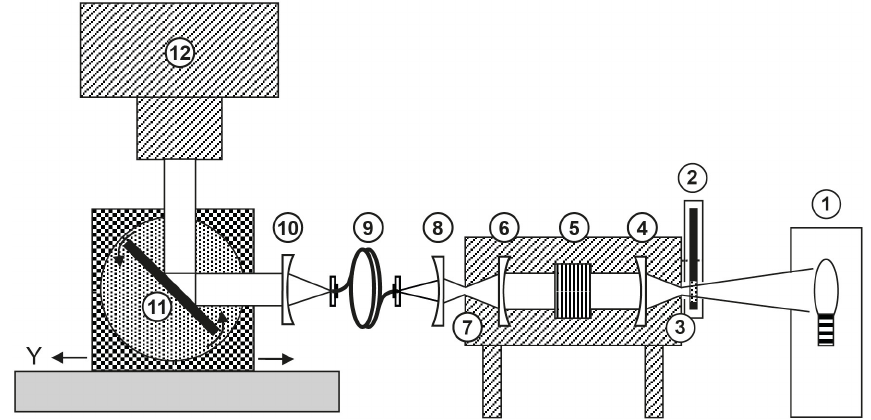
Figure 4: Monochromator setup for spectral measurements. 1 (cid:13) Lamp, 2 (cid:13) Long pass and/or neutral density filter in turnable wheel, 3 (cid:13) Entrance slit, 4 (cid:13) , 6 (cid:13) , 8 (cid:13) , 10 (cid:13) Parabolic mirror, 5 (cid:13) Grating mounted on turret, 7 (cid:13) Exit slit, 9 (cid:13) Optical fiber, 11 (cid:13) Folding mirror, 12 (cid:13)